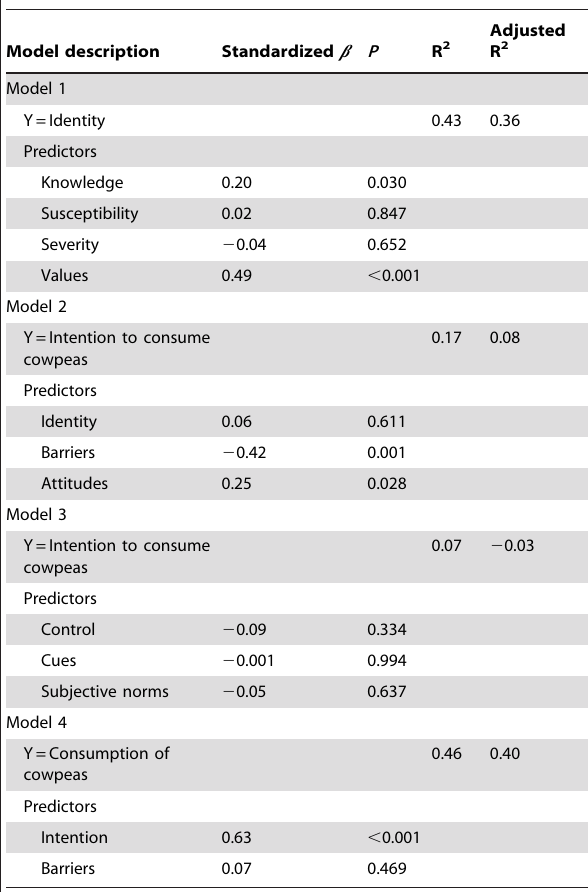
Table 6. Constructs predicting health behaviour identity associated with cowpeas, intention to give cowpeas and giving cowpeas to schoolchildren in northern Ghana 1